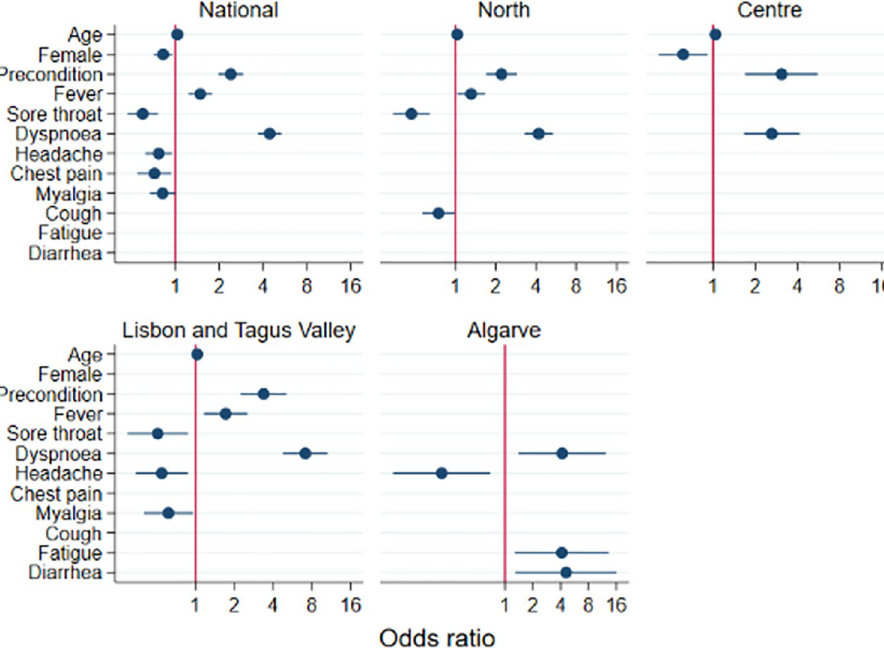
Fig 3. Predictors and 95% confidence intervals of hospitalisation using multivariate analysis, at the national level and by health region, among confirmed cases of COVID-19, March-April 2020 (N = 5,298). Estimates for some predictors are missing because those were not retained by the model using a backwards stepwise model